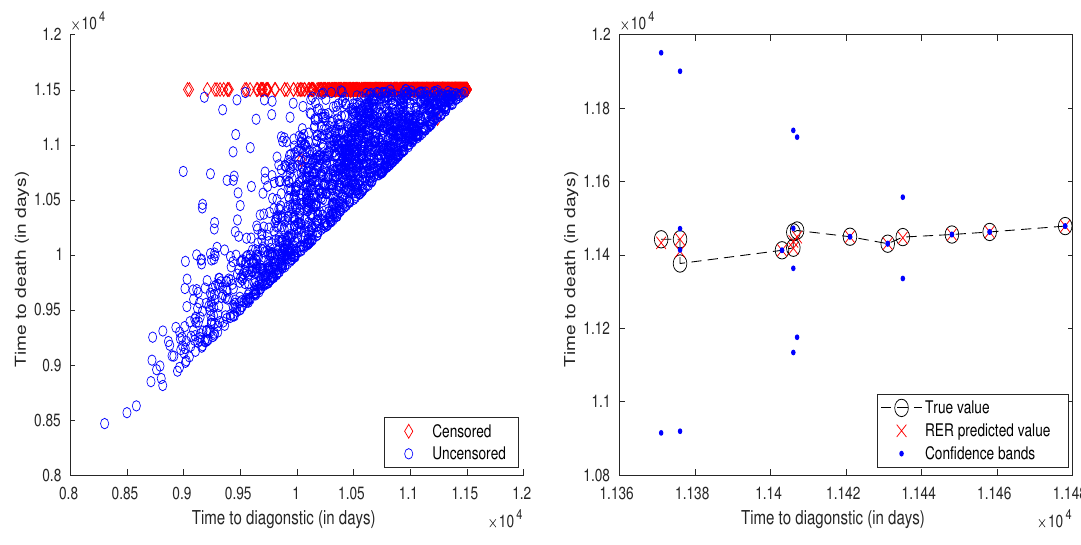
Figure 11: Australian AIDS survival scatter plot of censored / uncensored data. (left) RER prediction of survival time versus time to diagnosis for AIDS patients with pointwise interval confidence.